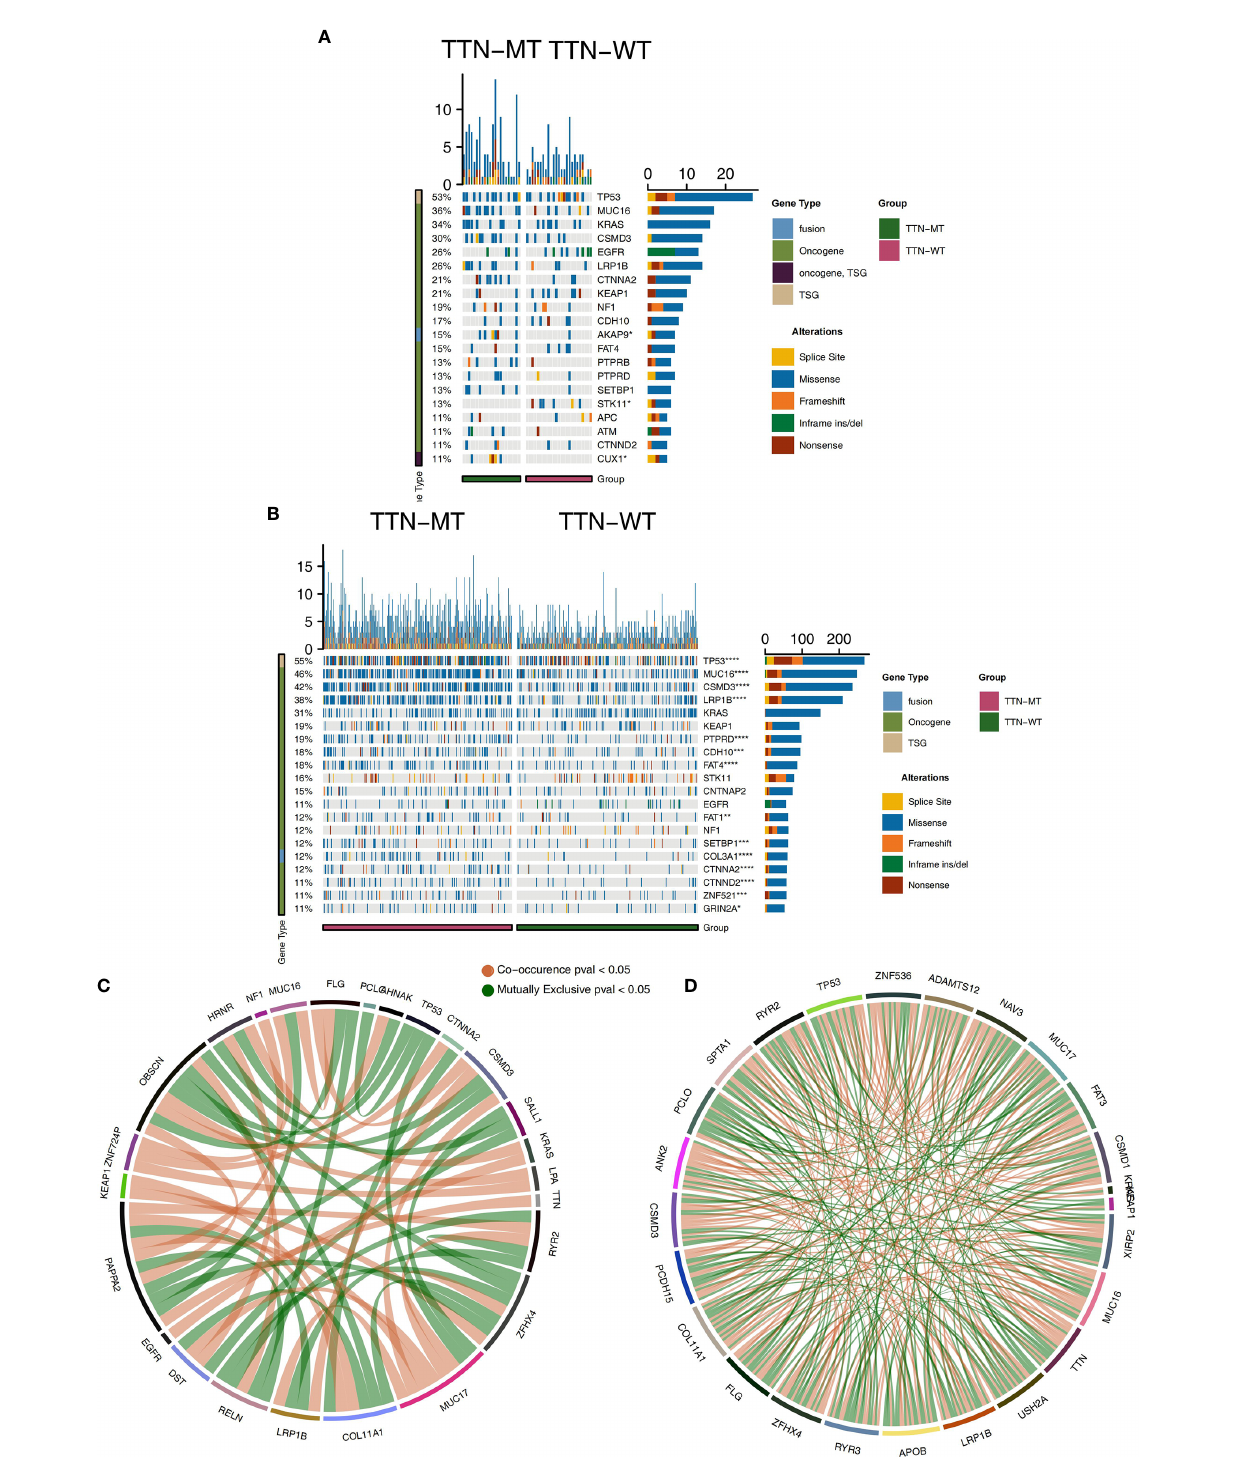
FIGURE 2 | Genomic pro fi les of LUAD patients. The Top 20 mutated driver genes in the ICI-cohort (A) and the TCGA-LUAD cohort (B) . Ribbon plot showing the co-occurrence (or mutually exclusive relation) between pairs of mutated driver genes in the ICI-cohort (C) and the TCGA-LUAD cohort (D) . *P < 0.05; **P < 0.01; ***P < 0.001; ****P <